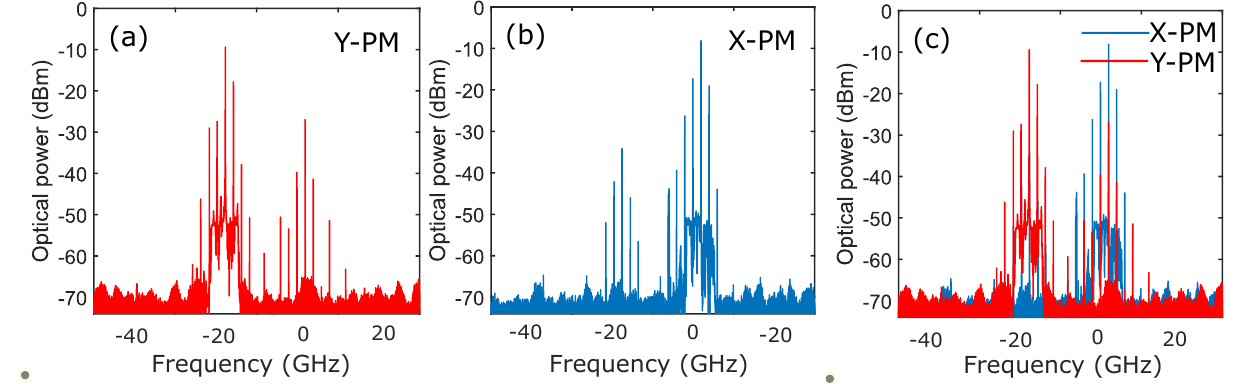
Figure 4. Bifurcation scenarios resulting in the excitation of the depressed polarization mode. These optical spectra are obtained for detuning ∆ ν = 1.6 GHz and injected comb spacing Ω = 2 GHz. ( a ) Stable output at P inj = 3 µW, ( b ) wave mixing at P inj = 16 µW, ( c ) two polarizations comb at P inj = 48 µW, ( d ) two polarization harmonics comb at P inj = 112 µW, ( e ) two polarization complex dynamics at P inj = 208 µW and ( f ) X-polarization comb at P inj = 240 µW.